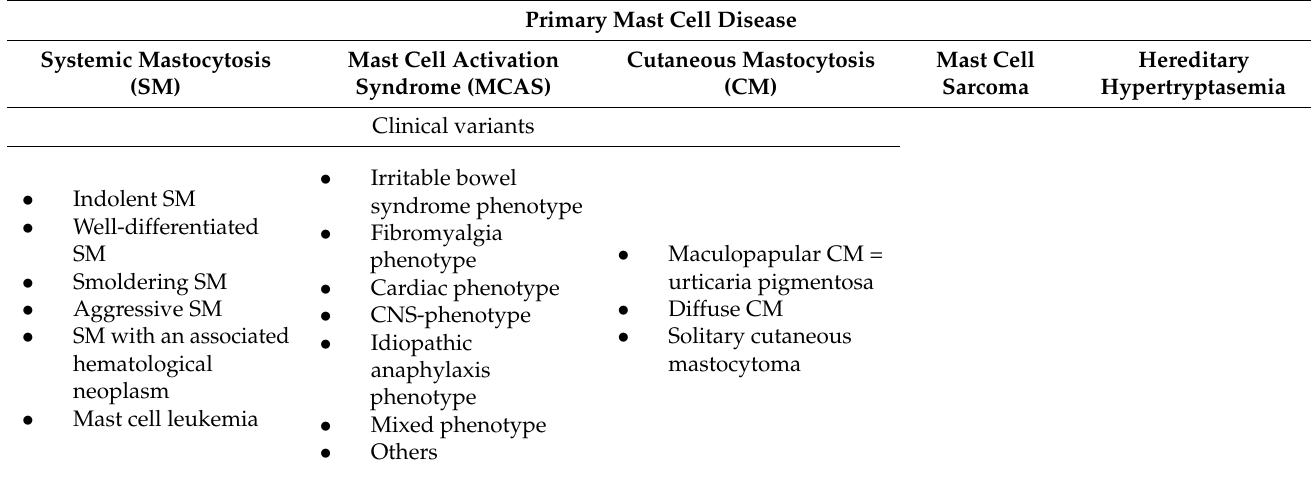
Table 1. Classification of primary mast cell